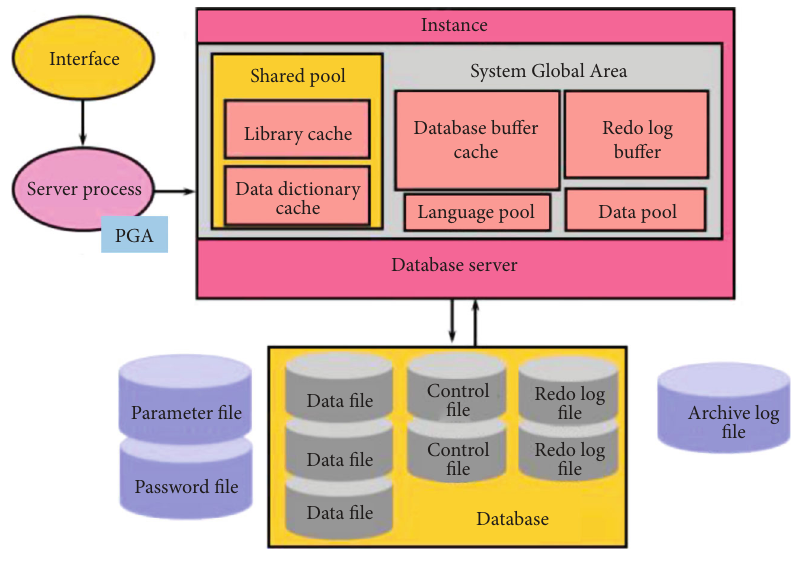
Figure 2: Basic architecture of the database system operation.